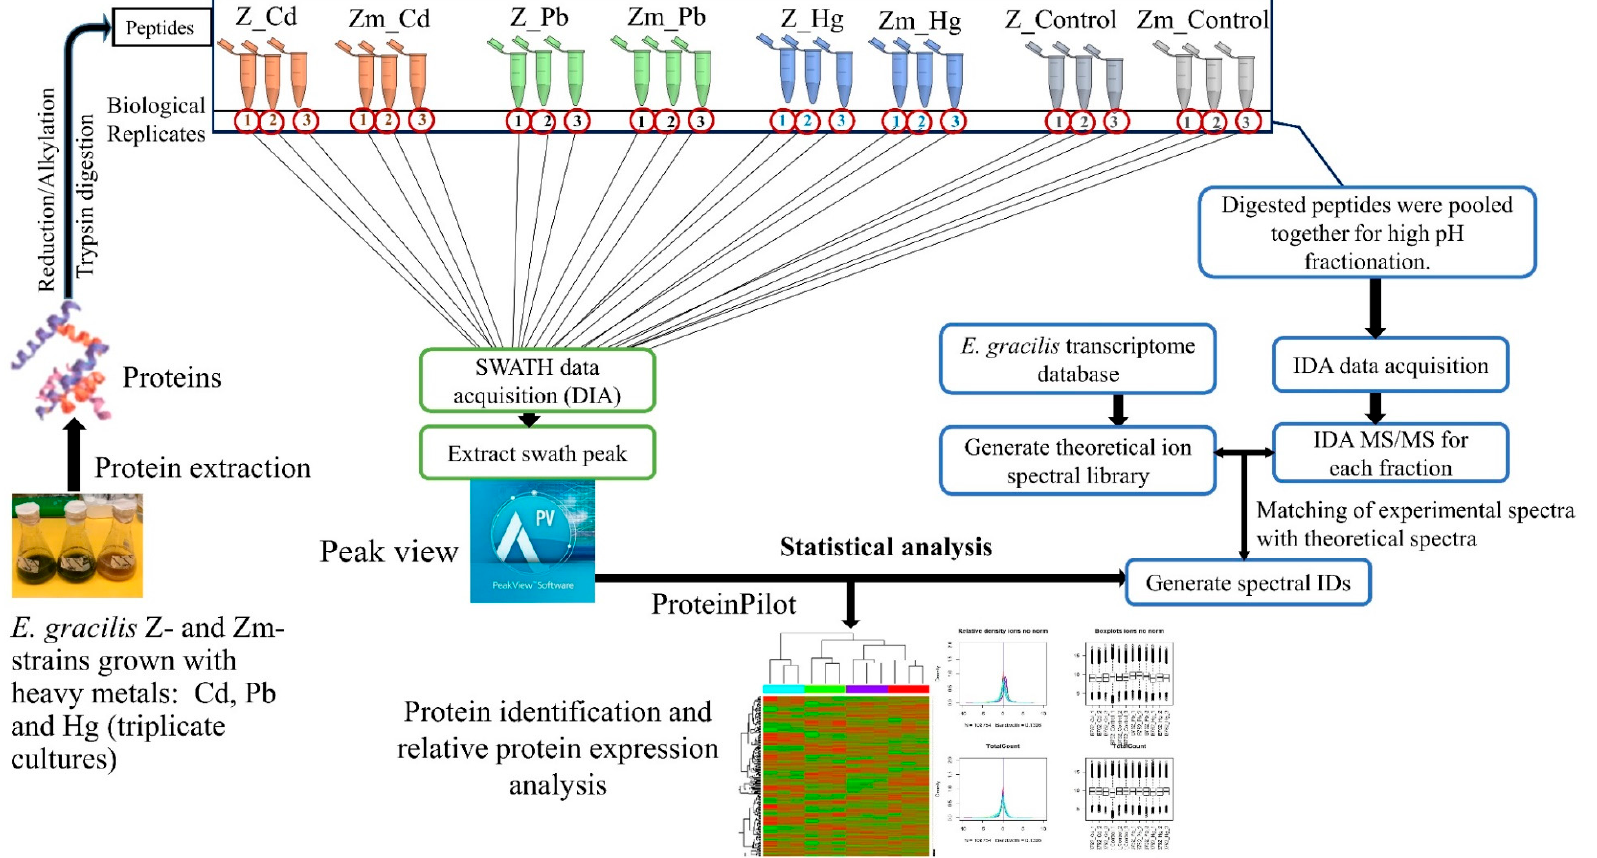
Figure 1. Workflow of SWATH-MS. The empirical ion / spectral library was generated by IDA-MS. SWATH acquisition enabled comparison of the spectra to the spectral library and label-free relative quantification of proteins. The relative abundance of proteins was compared between heavy metal treated and untreated control samples. Statistical analysis was performed as stated in Section 2.9